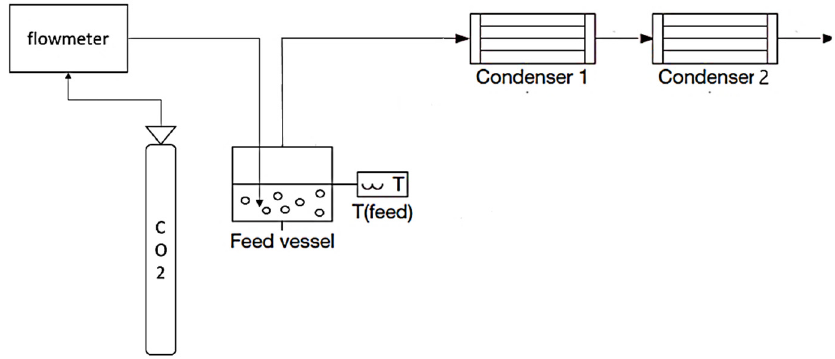
Figure 1. Diagram of the experimental setup of fractionated condensation with CO 2 stripping gas with two condensers connected in series.